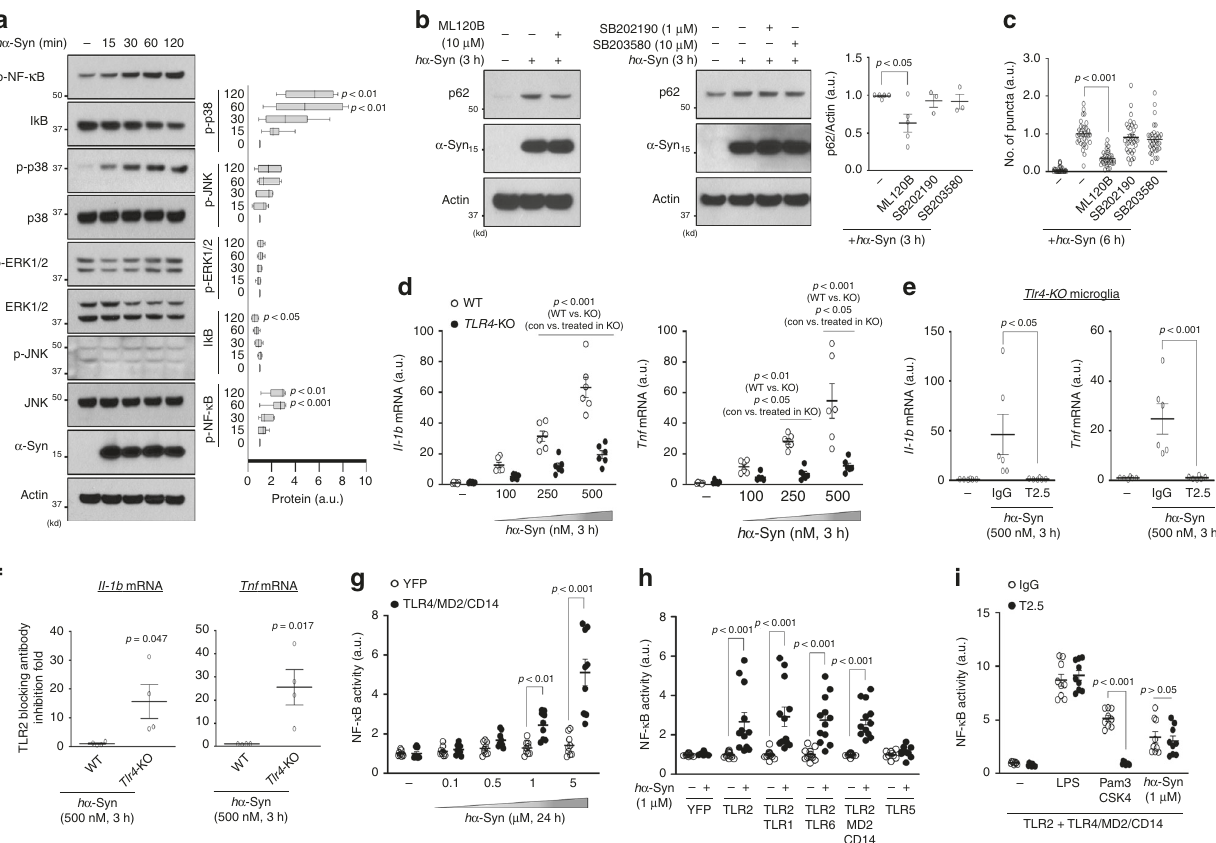
Fig. 5 NF- κ B mediates α -synuclein-TLR4 signaling and p62 induction. a WT microglia were treated with 250 nM h α -Syn protein for the indicated time and assayed for W.B using antibodies as indicated. The levels of proteins were quanti fi ed in the right panel ( n = 6). p -values were calculated by one-way ANOVA with Newman – Keuls post hoc test. F(4,24) = 9.196, p = 0.0001 for p-NF- κ B, F(4,24) = 4.530, p = 0.0072 for IkB, F(4,24) = 0.8644, p = 0.4994 for p-ERK1/2, F(4,24) = 1.369, p = 0.2741 for p-JNK, F(4,24) = 5.372, p = 0.0031 for p-p38. b , c Cells were pretreated with ML-120B, an IKK-2 inhibitor, or SB203580 and SB202190, two different p38 inhibitors, for indicated concentrations before 250 nM h α -Syn protein treatment, and assayed for W.B ( b , n = 3 – 5, F(3,12) = 3.750, p = 0.0413) or immunostaining ( c , n = 33, F(4,160) = 56.21, p = 1.53E-29). The levels of proteins were quanti fi ed in the right panel. The number of h α -Syn/ubiquitin-positive puncta was counted and quanti fi ed ( c ). p -values were calculated by one-way ANOVA with Newman – Keuls post hoc test. d – f Microglia obtained from WT mice and Tlr4 -KO mice were treated with h α -Syn protein for 3 h with indicated concentration without ( d , n = 6) or with ( e ( n = 6), f ( n = 4)) TLR2-blocking antibody (T2.5), and assayed for RT-qPCR using primers for Il-1b (left panel, F(3,40) = 20.70, p = 2.95E-08 for h α -Syn-genotype interaction; F(3,40) = 69.43, p = 6.55E-16 for h α -Syn; F(1,40) = 69.57, p = 2.74E-10 for genotype) and Tnf (right panel, F(3,40) = 10.12, p = 4.32E-05 for h α -Syn-genotype interaction; F(3,40) = 21.73, p = 1.64E-08 for h α -Syn; F(1,40) = 34.36, p = 7.39E-07 for genotype). p -values were calculated by two-way ANOVA with Bonferroni post hoc test (wt vs ko in d ), one-way ANOVA with Newman – Keuls post hoc test (non-treated vs. treated in d , e ; F(3,20) = 22.11, p = 1.46E-06 for Il-1b , F(3,20) = 11.88, p = 0.0001 for Tnf ), and unpaired two-tailed Student ’ s t test ( f ). g – i HEK293T cells were transfected with a luciferase vector that expresses luciferase under the promoter containing NF- κ B-binding elements, and various TLRs. Then, cells were treated h α -Syn protein with indicated concentration ( g ( n = 9), h ( n = 9 – 12), i ( n = 9)), 50 ng/ml LPS ( i ), or Pam 3 CSK 4 ( i ) for 24 h without ( g , h ) or with ( i ) 10 µ g/ml TLR2-blocking antibody (T2.5) and control IgG. p -values were calculated by two-way ANOVA with Bonferroni post hoc test. In g , F(4,80) = 19.63, p = 2.74E-11 for interaction; F(4,80) = 27.31, p = 2.66E-14 for h α -Syn; F(1,80) = 47.95, p = 9.90E-10 for protein overexpression. In h , F(5,126) = 6.070, p = 4.54E-05 for interaction; F(5,126) = 6.070, p = 4.54E-05 for h α -Syn; F(1,126) = 73.83, p = 2.77E-14 for protein overexpression. In ( i ), F(3,64) = 16.98, p = 3.19E-08 for interaction; F(3,64) = 177.4, p = 5.90E-31 for stimuli; F(1,64) = 17.47, p = 9.03E-05 for antibody. Data are representative of at least three independent experiments. All values are reported as mean ±